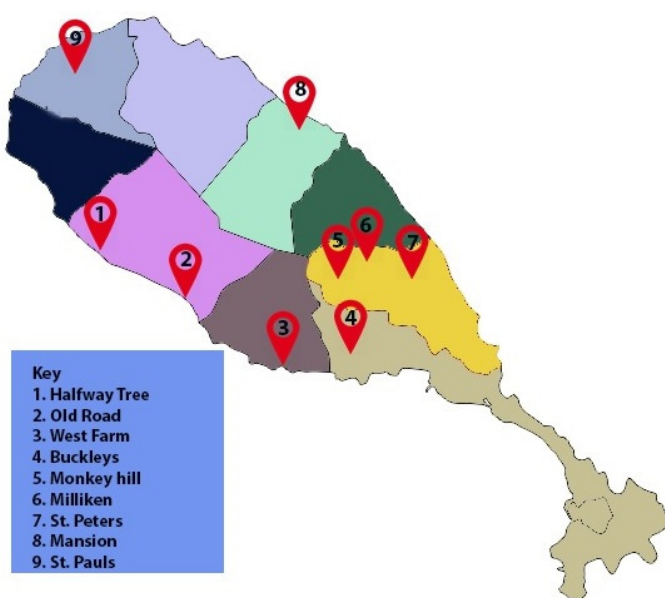
Figure 5. Map of St. Kitts showing the sampling areas.